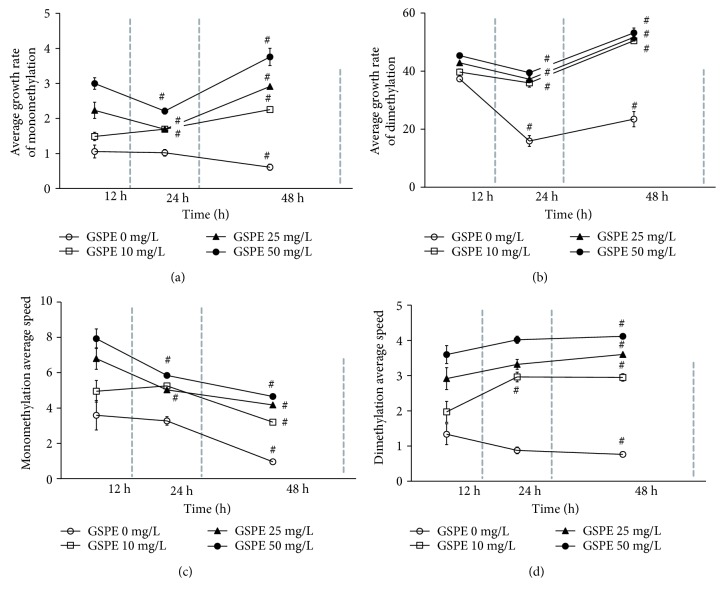
Effects of grape seed procyanidin extract on average growth rate of methylation and average methylation speed (mean ± SD, n = 3). #Versus 0–12 h groups at the same dose of GSPE, P < 0.05. The average growth rates of monomethylation and dimethylation in the GSPE treatment groups at 12, 24, and 48 h were higher than those in the GSPE untreated group (a, b). Furthermore, GSPE promoted the average methylation speed of monomethylation and dimethylation at 12, 24, and 48 h compared with the GSPE untreated group (c, d).